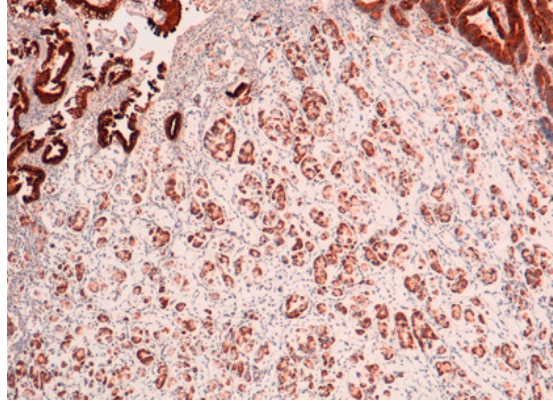
Figure 2. MUC6 positivity in Pen A ECG (50×).